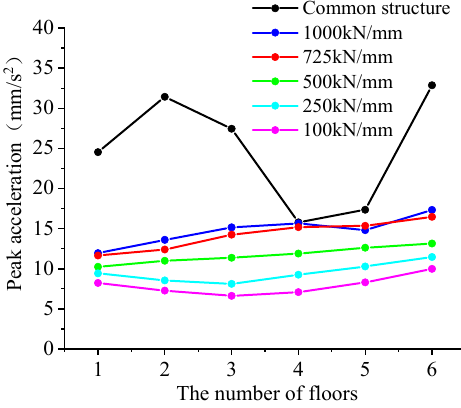
Figure 16. Peak acceleration as the stiffness changes.